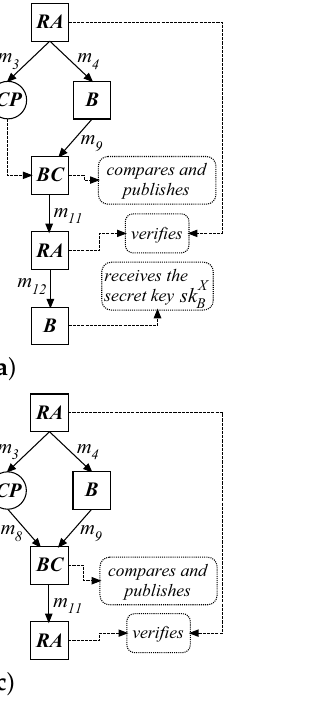
( E ( N )) ( b ), and S RA and E RA ( c ) when CP is corrupt. The pk X B pk X CP